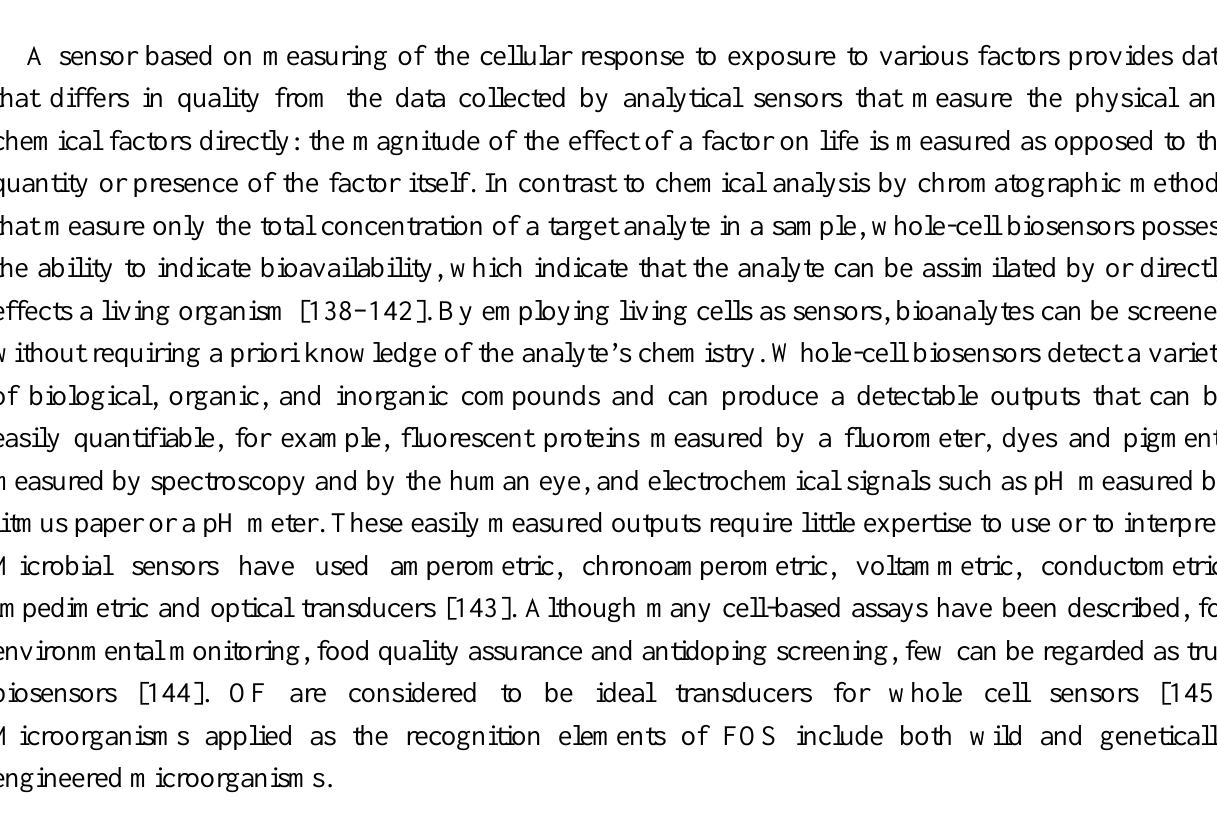
Figure 14. Polychlorinated biphenyls (PCB) degradation pathway by Pseudomonas sp . P2 (Adopted from